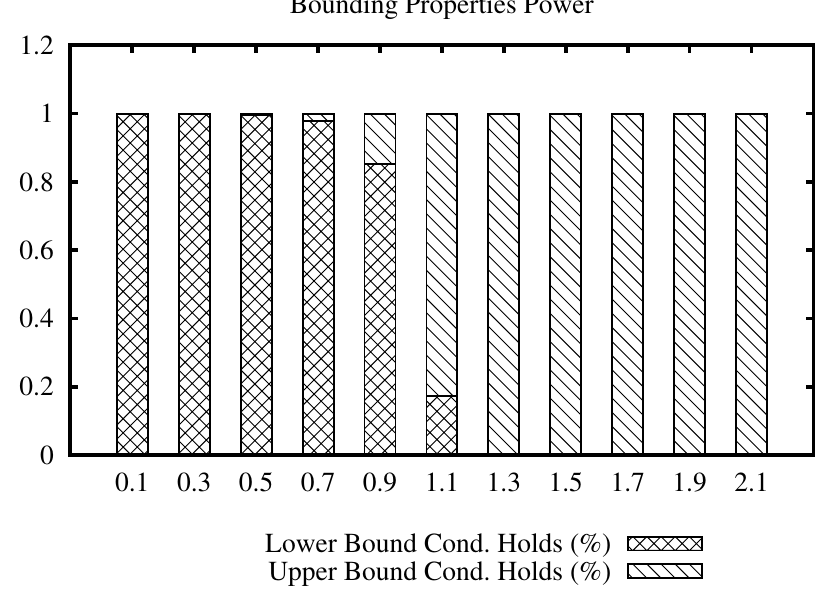
Figure 3. Percentage of filtering that each bounding property can achieve within the range of radius of the join algorithm using the Corel data set.